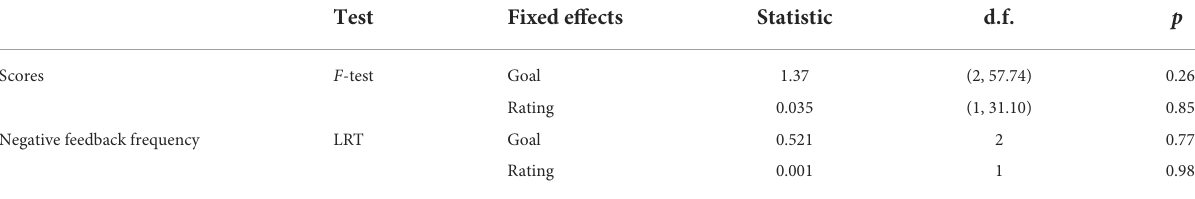
TABLE 1 Summary of statistical analyses for behavioral